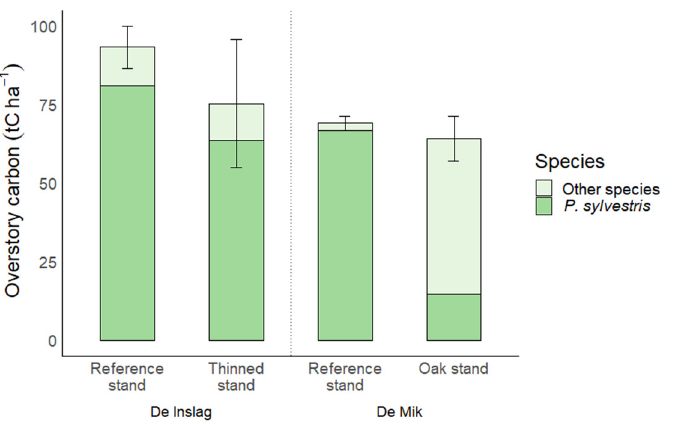
Figure 3. C stocks (tC ha − 1 ) in the aboveground biomass of the overstory of the investigated stands with differentiation between the contribution of Scots pine (dark green) and of the other species (light green).